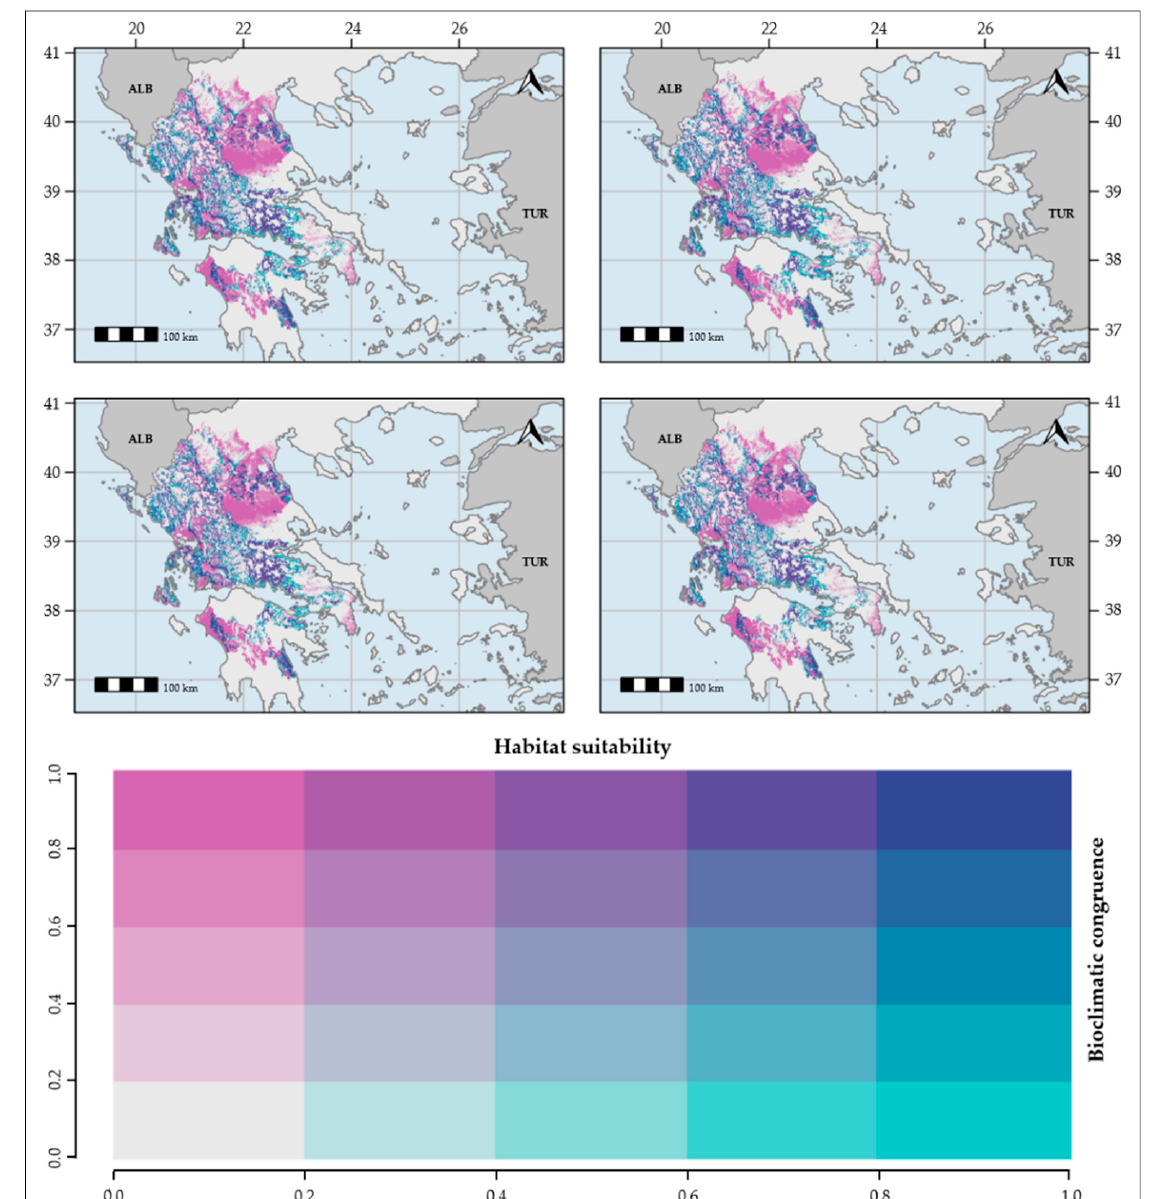
Figure 2. Bioclimatic consistency maps for both thinning procedures (geographical and environmental) of Ophrys helenae . From top-left to bottom-right: geographically-thinned, based on WorldClim; geographically-thinned, based on CHELSA; Environmentally-thinned, based on WorldClim; environmentally-thinned, based on CHELSA.